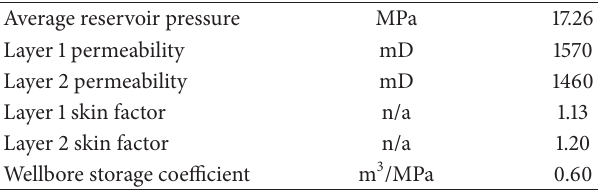
Table 6: Interpretation results of Field Test One (Well 5-227).